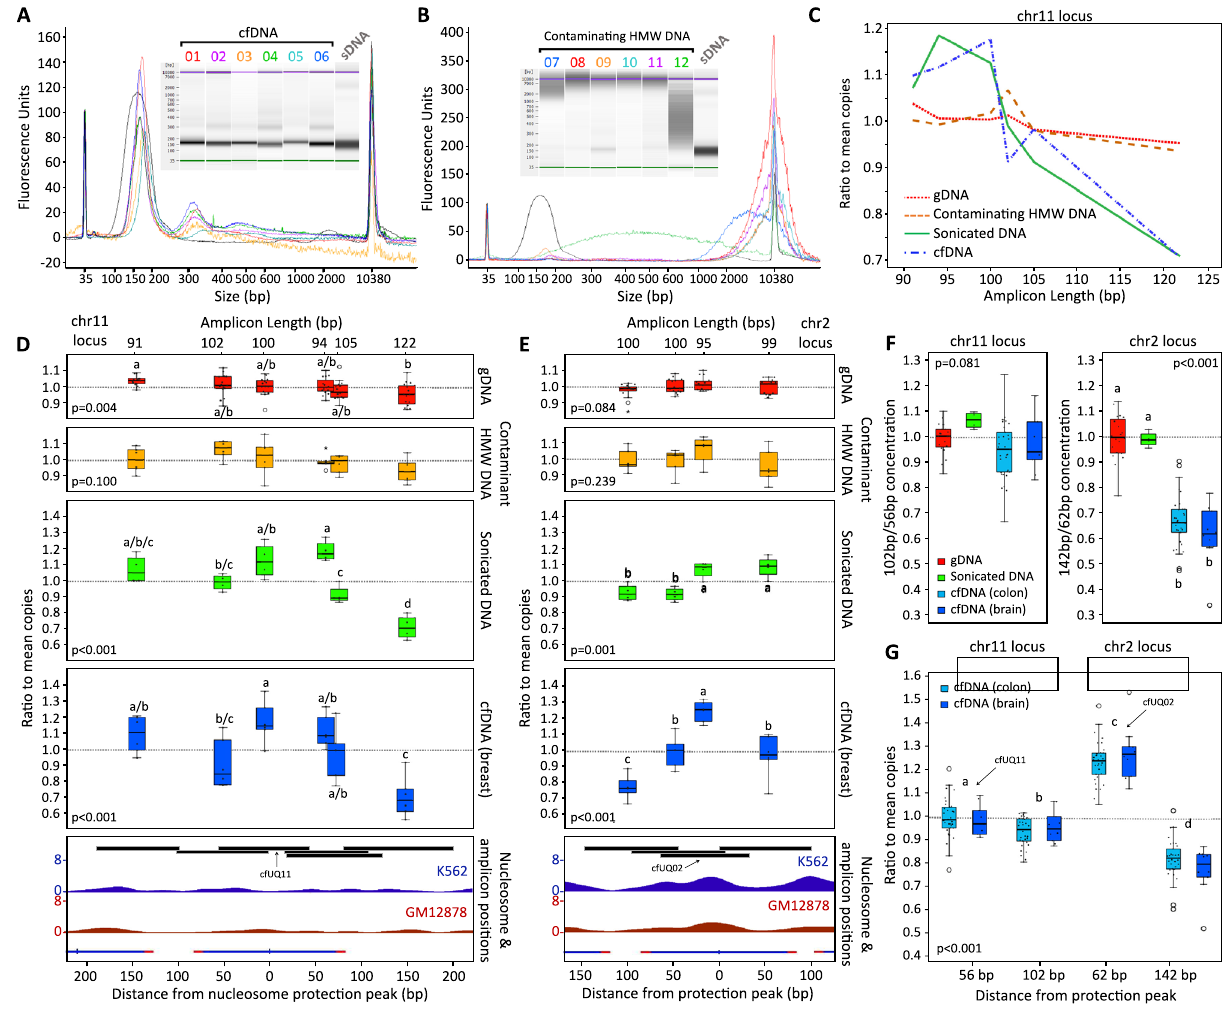
Figure 6. Effects of amplicon length and distance from nucleosome protection peak on intact copies in cfDNA. ( A – B ) Electropherograms and pseudo-gel images from Agilent 2100 Bioanalyzer with a High Sensitivity DNA Chip (2100 Expert version B.02.10.SI764). DNA samples are from plasma of breast cancer patients, except sample labelled sDNA which is a pooled buffy coat gDNA sample sonicated and gel-purified to produce a similar fragment size distribution to cfDNA. Samples classified as true cfDNA samples ( A ) were isolated using our in-house phenol–chloroform method (1–4) and QIAamp Circulating Nucleic Acid Kit with EconoSpin All-In-One Mini Spin Columns (Epoch Life Sciences) instead of columns supplied with the kit (5–6). Samples classified as contaminating buffy coat DNA ( B ) were isolated using QIAamp Circulating Nucleic Acid Kit (7–11) and in-house phenol–chloroform method (12). ( C – E ) Plots of ratio to mean copies (assay/sample mean) against amplicon length ( C ) and against distance from nucleosome protection peak ( D ) for assays targeting chr11 nucleosome protection peak locus, and against distance from nucleosome protection peak for assays targeting chr2 locus ( E ). Box and whisker plots are centred above corresponding amplicon positions for each assay, along with cell line data of nucleosome signal (K652 and GM12878) from Kundaje et al. (2012) 29 and nucleosome protection peak position (blue tick) from Snyder et al. (2016) 11 , adjoined by characteristic 146 bp nucleosomal DNA length (blue) and 10 bp linker DNA (red). Sample numbers for each sample type are gDNA = 15, buffy coat DNA = 6, breast cancer cfDNA = 6, and sonicated DNA = 1 (four technical replicates). ( F-G ) Box and whisker plots for chr11 102 bp/56 bp and chr2 142 bp/62 bp differential distance from protection peak copy count ratios ( F ), as well as the ratio to mean copies across the two loci for cfDNA samples ( G ). Sample numbers for each sample type are gDNA = 20, colon cancer cfDNA = 34, brain cancer cfDNA = 10, and sonicated DNA = 1 (four technical replicates). All four amplicons are 100 bp in length. Letters above or below box and whisker plots ( D – G ) represent homogenous subsets determined by post hoc Tukey’s HSD analyses (α = 0.05) of one- way ANOVAs (p values on plots). The bottom line of each box represents the 25th percentile, top line the 75th percentile, and thick middle line the median. Whiskers extend up to a maximum of 1.5 times the height of the box. Any values that fall outside this range are classified as outliers (circles). Values that are greater than 3 times the height of the box are classified as extreme outliers